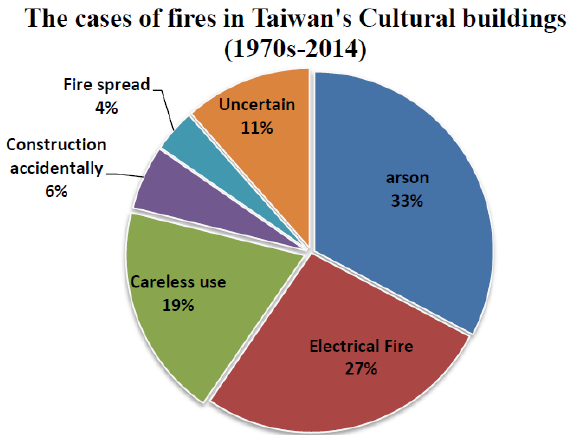
Figure1. The causes of fires happened in Taiwan’s cultural heritages and historical buildings from the 1970s to